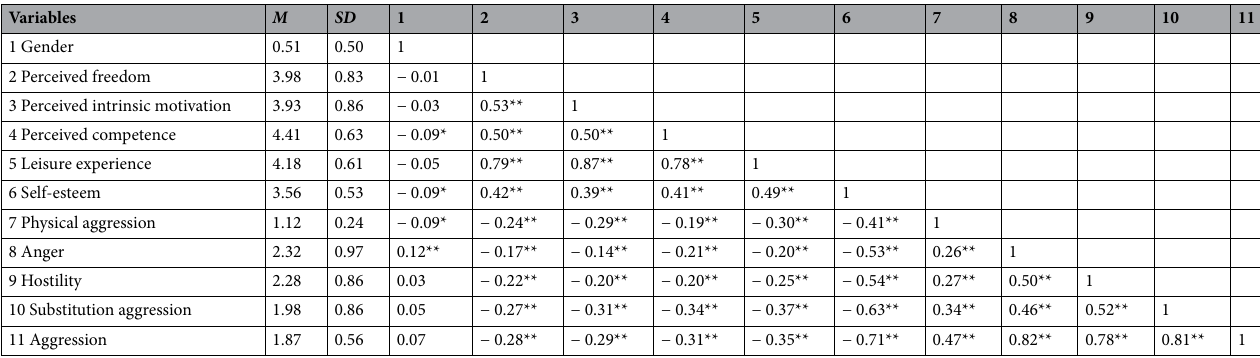
Table 1. Descriptive statistics and correlation coefficients ( N = 628). * p < 0.05, ** p < 0.01. The gender variable was treated as a dummy variable, 0 = male, 1 = female. Leisure experience is the sum of perceived freedom,